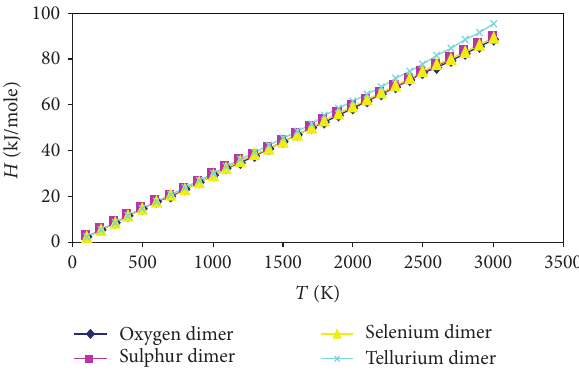
F 3: Variation of entropy ( S ) with temperature ( T ).